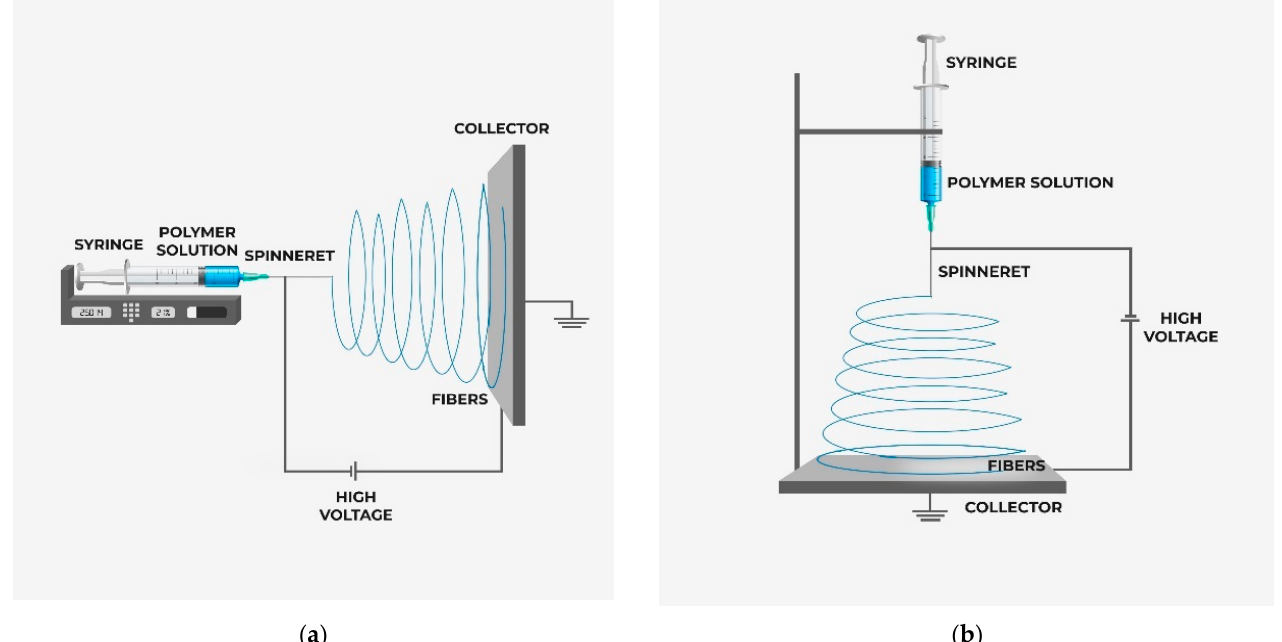
Membranes 2021 , 11 , x FOR PEER REVIEW Figure 13. Schematic diagram of electrospinning setup: ( a ) horizontal; ( b ) vertical (adapted with permission from [212] ).